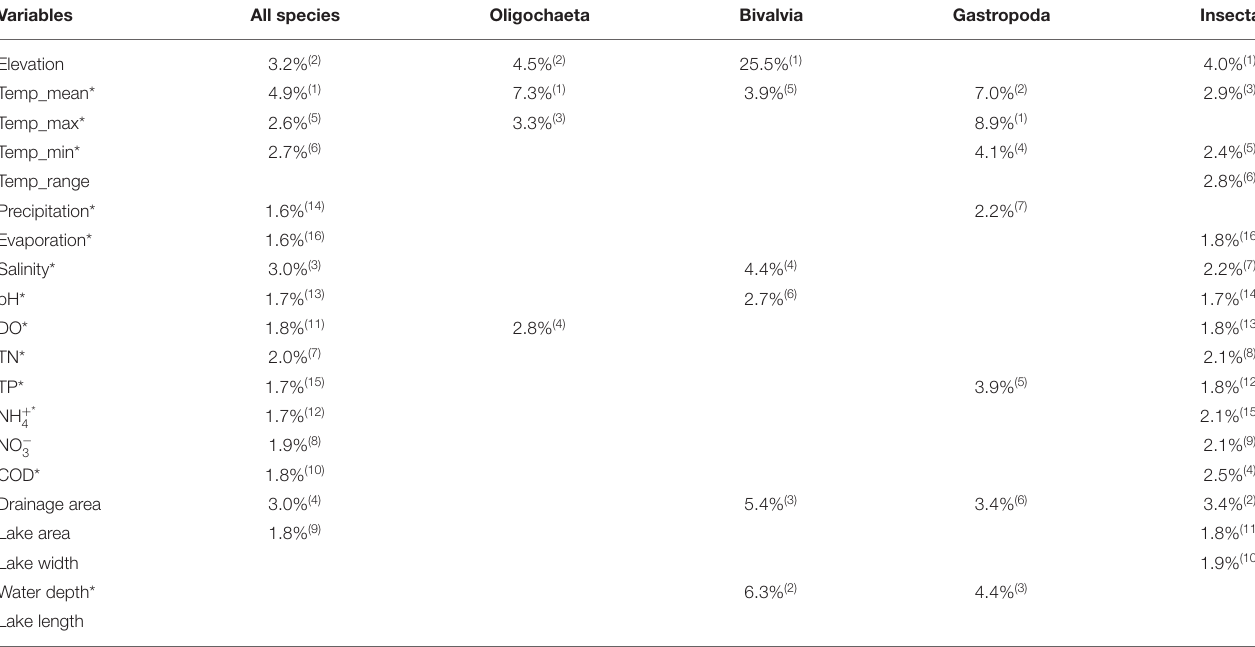
TABLE 1 | Explanations (%) and order of entry of significant explanatory variables in the forward selection with Monte Carlo permutation tests to the assemblage variation of benthic macroinvertebrates ( α = 0.05).